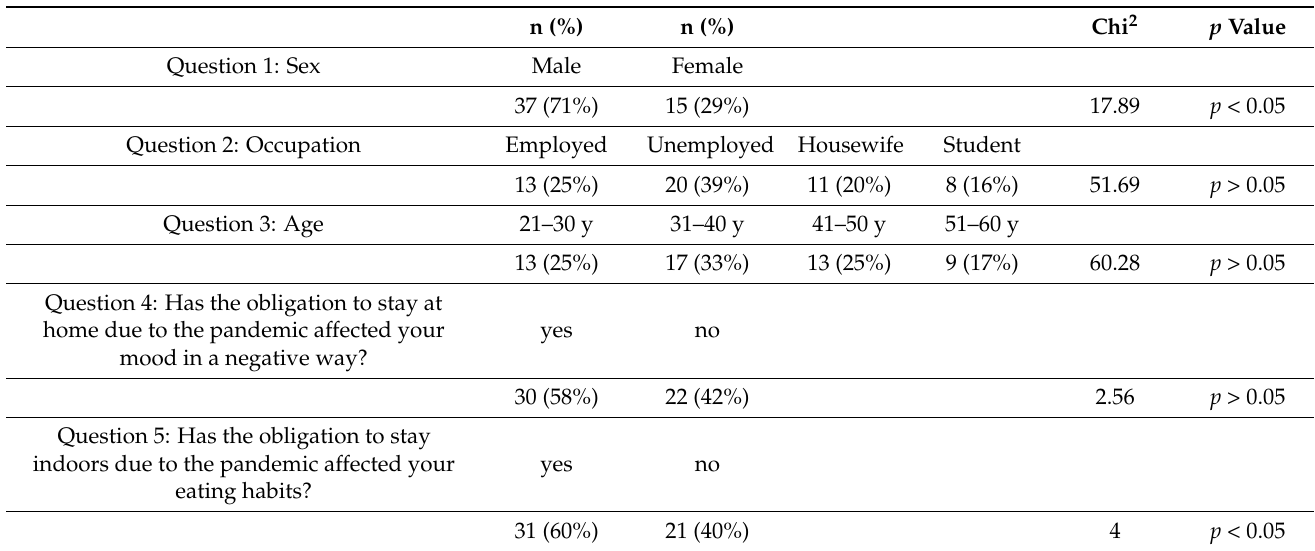
Table 1. Statements from patients with obesity on the waiting list for bariatric surgery on the impact of the COVID-19 lockdown on their mental